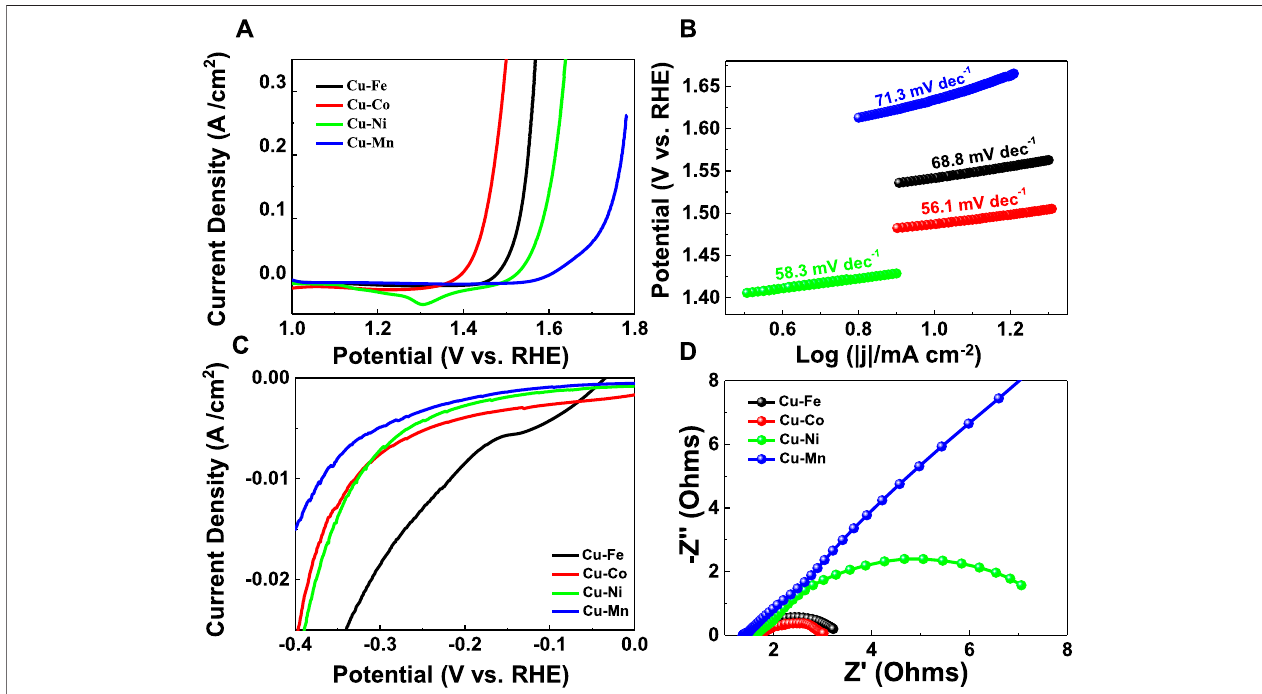
FIGURE4| (A) TEM image and (B) HRTEM image ofPt – Cu. (C) Element mappingofPt – Cu. LSVcurvesof (D) HER tests and (E) OER tests forthe Pt – Cu sample.